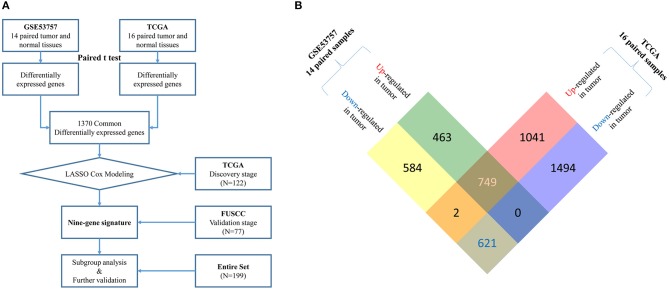
(A) Flow chart of multi-gene signature identification and validation.Raw microarray mRNA expression data of 14 and 16 paired tumor and normal tissue samples from stage III ccRCC patients was downloaded from GEO (GSE53757) and TCGA database, respectively. Differentially expressed genes (DEGs) were identified based on gene expression data of paired samples from these two datasets using paired t-test. 1370 common DEGs were found between two datasets (see more detail in B). Then, we used a LASSO cox regression model and selected nine genes highly associated with survival in these 1370 common DEGs in a TCGA discovery cohort (N = 122). Later, this nine-gene signature was further tested in the FUSCC validation cohort (N = 77). Finally, subgroup analysis and further validation were performed in the entire cohort (N = 199). (B) Identification of common up-regulated genes and down-regulated genes (DEGs) from two datasets. By analyzing 14 paired tumor and normal microarray mRNA expression data from stage III ccRCC patients in GSE53757, we identified 1,212 up-regulated and 1,207 down-regulated genes in tumor tissues. From 16 paired samples in TCGA, we identified 1,792 up-regulated and 2,115 down-regulated genes in tumor tissues. After analyzing the intersection of the two datasets, we finally located 749 common up-regulated genes and 621 common down-regulated genes (1,370 common DEGs).